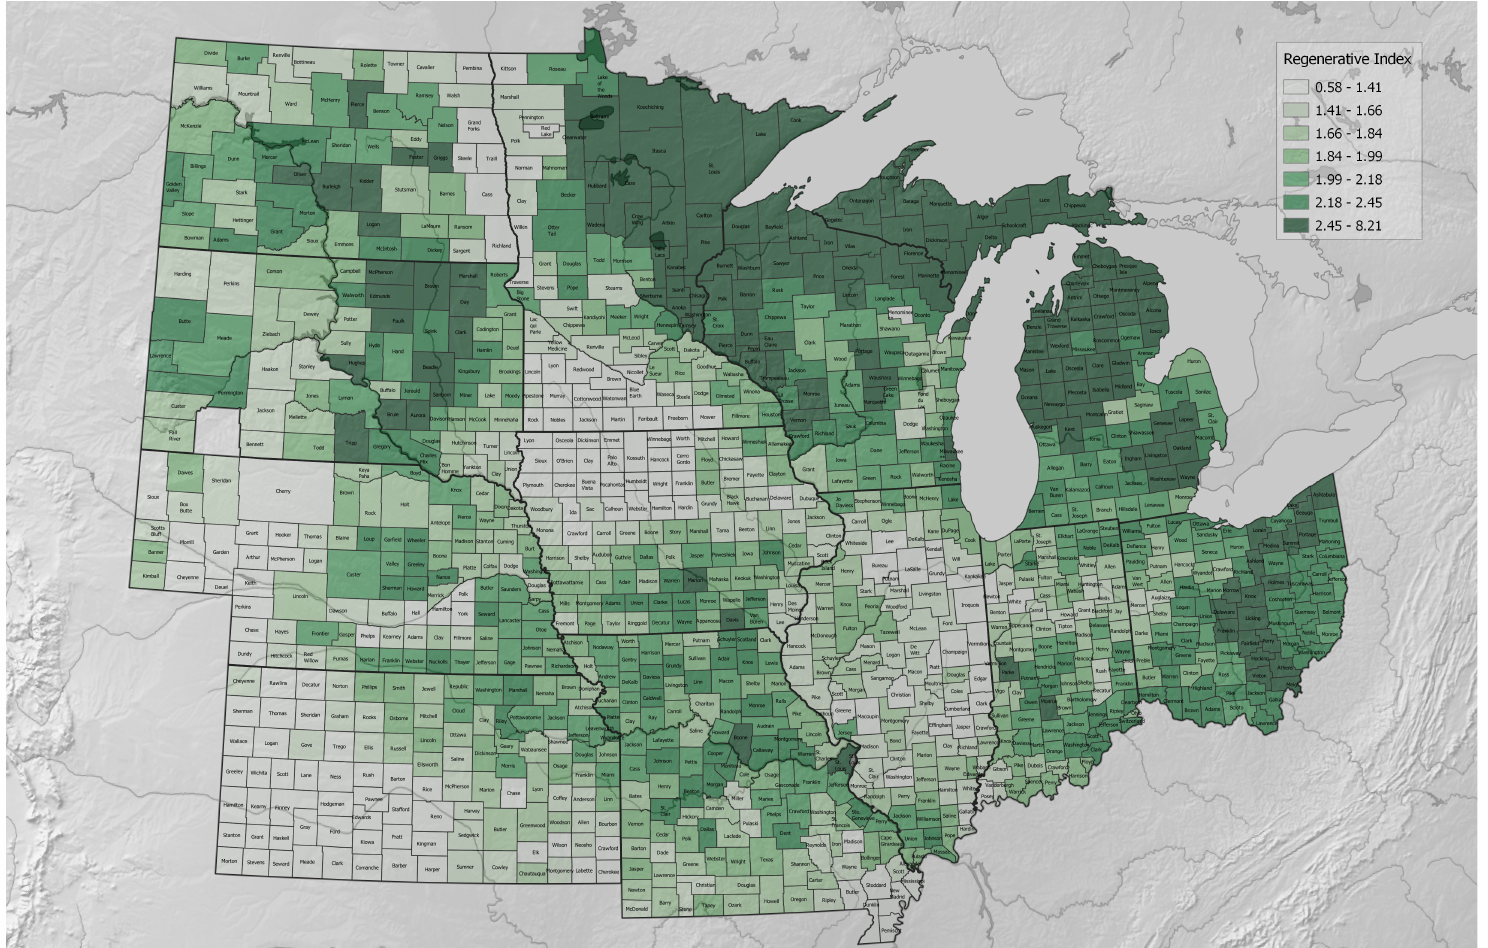
Figure 1. Regenerative–conventional agricultural index—a ratio between a ‘numerator’ composed of variables associated with regenerative agricultural lands and a ‘denominator’ composed of variables associated with conventional agricultural lands. Lower index values, thus, are associated with counties whose agricultural lands are more conventional. Higher index values are associated with counties whose agricultural lands are more